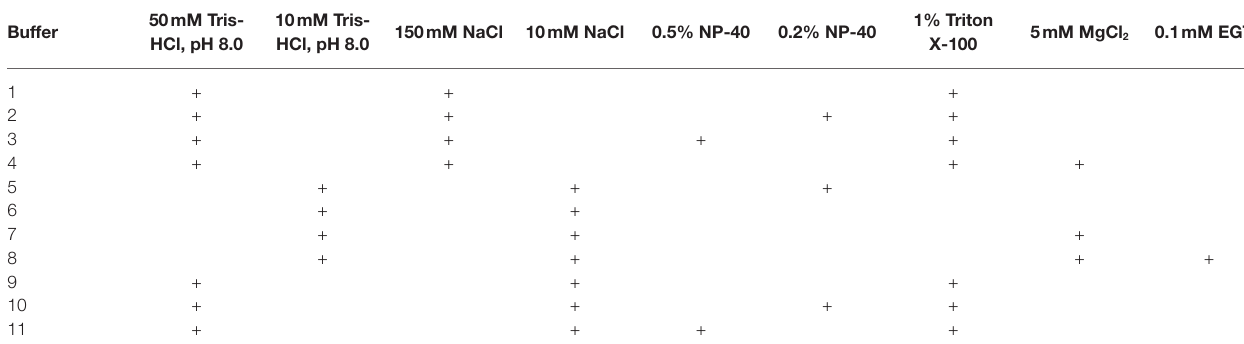
TABLE 2 | The lysis buffers studied.